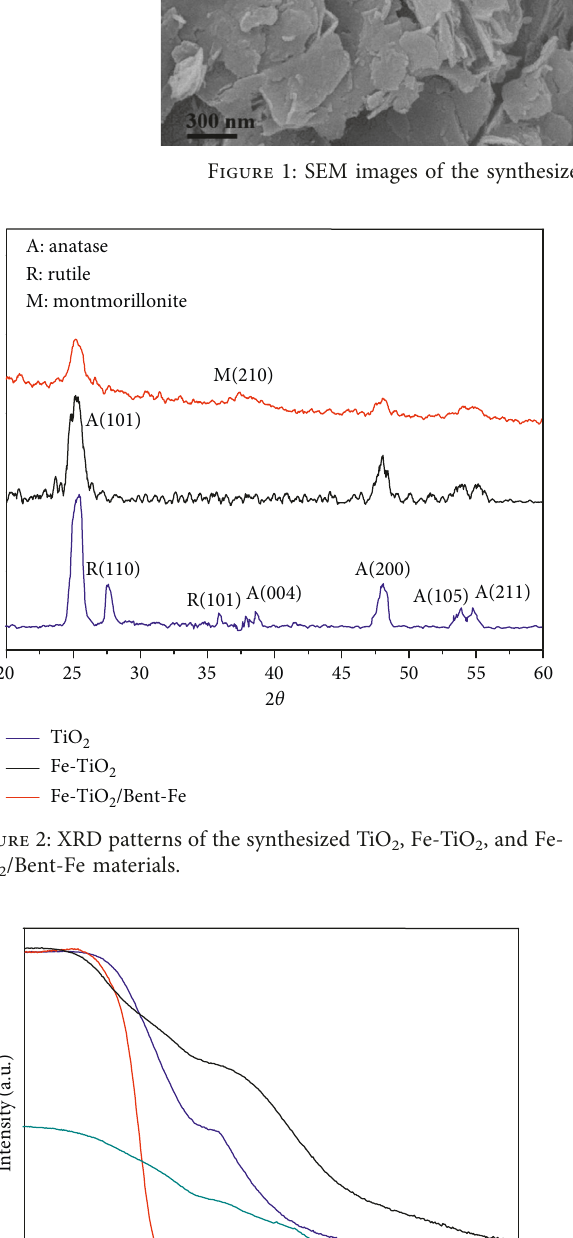
2 /Bent-Fe materials.